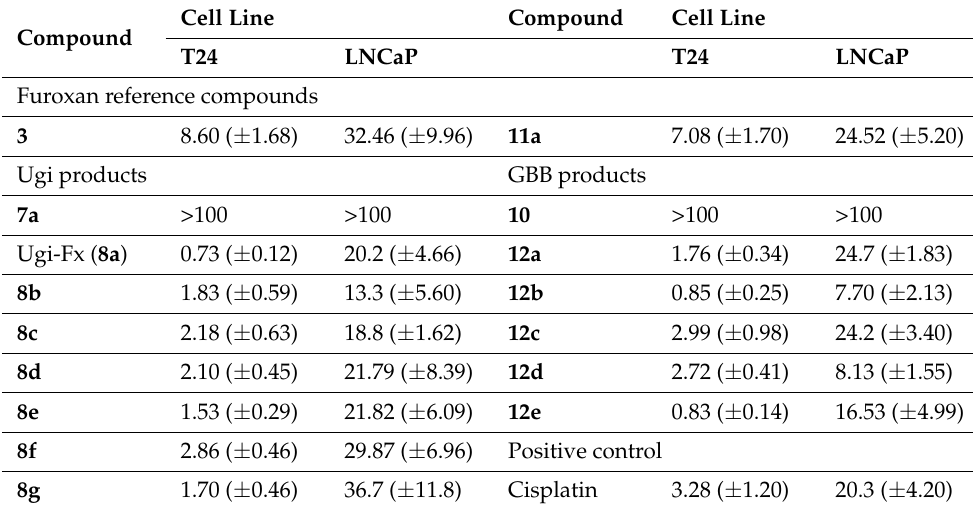
Table 2. Antiproliferative activity (GI 50 , µ M) a against bladder (T24) and prostate (LNCaP) human cancer cells of compounds obtained via Ugi and GBB reactions. Cell Line Compound